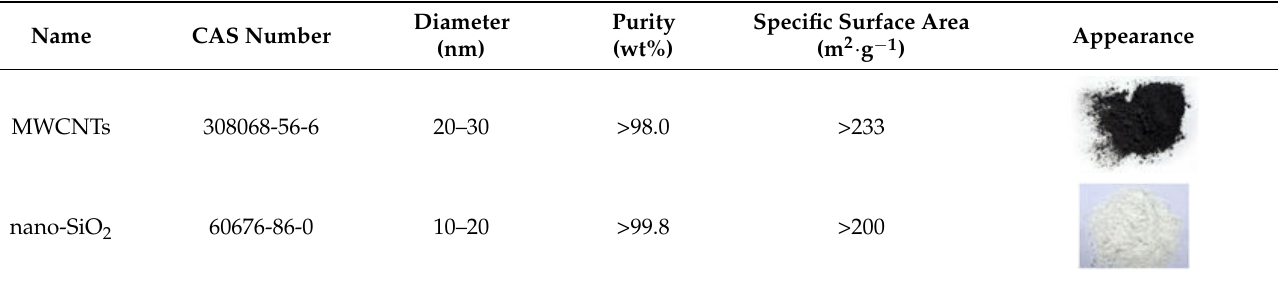
Table 3. Physicochemical properties of MWCNTs and nano-SiO 2